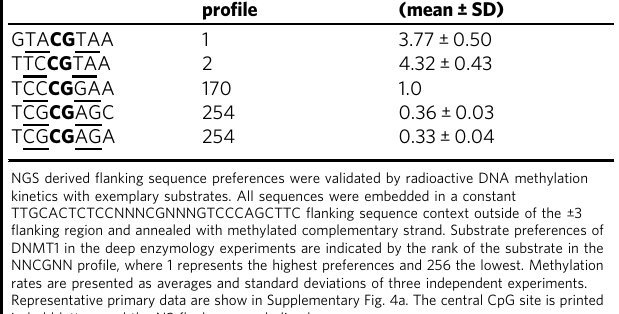
Table 1 Validation of the NGS pro fi les.